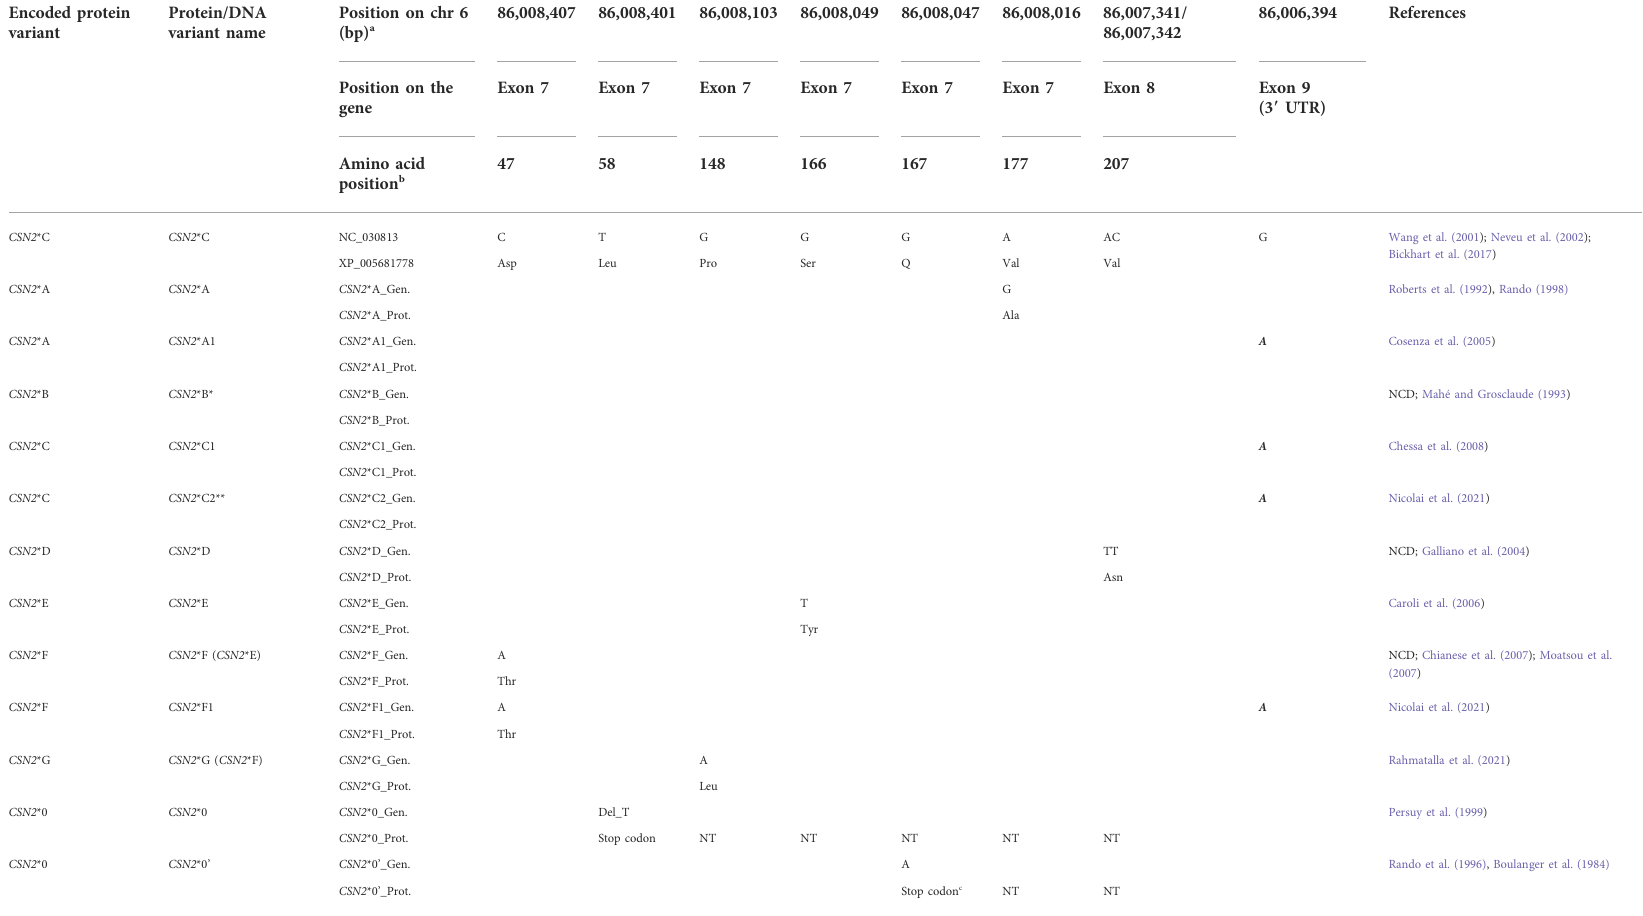
TABLE 1 Nucleotide and amino acid variants within the gene and mature protein of the CSN2 . Encoded protein